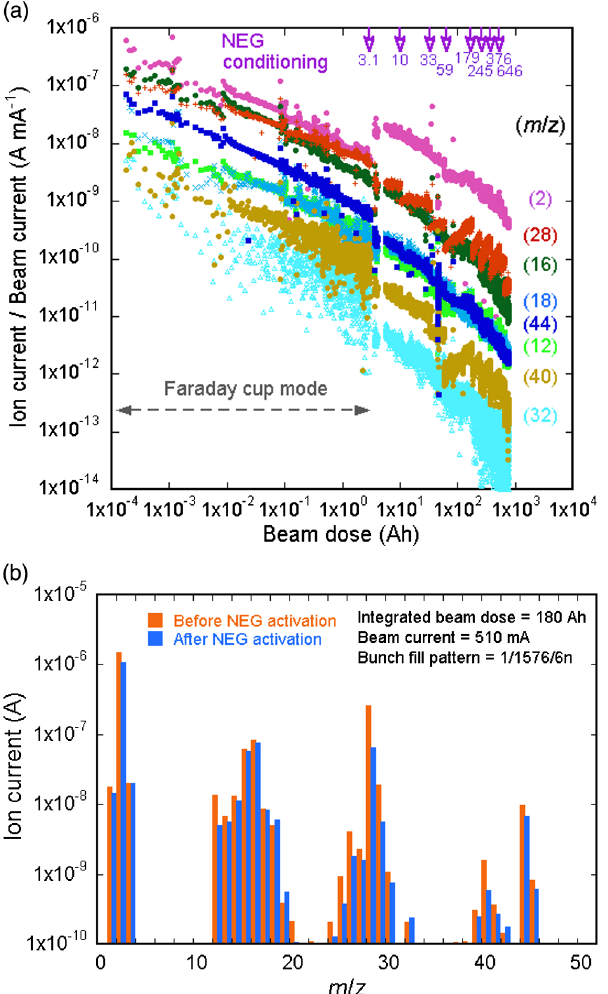
FIG. 5. (a) Ion currents for typical gases normalized by beam current (A mA − 1 ) measured by a residual gas analyzer in an arc section of LER as functions of the beam dose (Ah). (b) Mass spectra before and after the activation of NEG at a beam dose of approximately 180 Ah and a beam current of 510 mA.